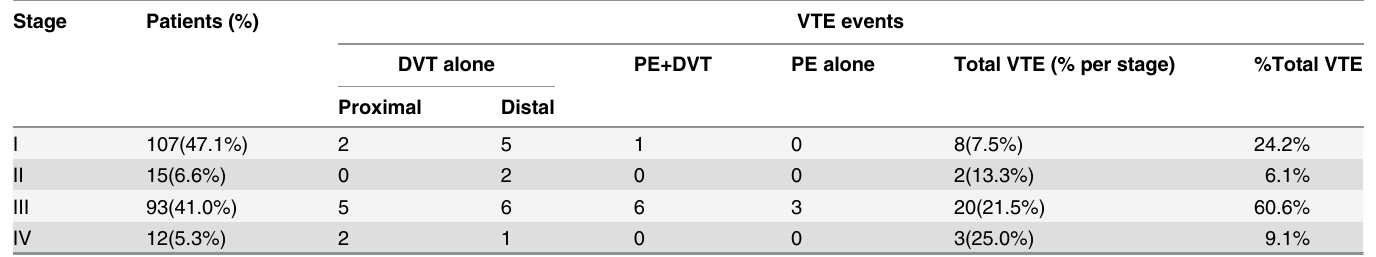
Table 3. Distribution of patients with ovarian clear cell carcinoma by stage and number of VTE.